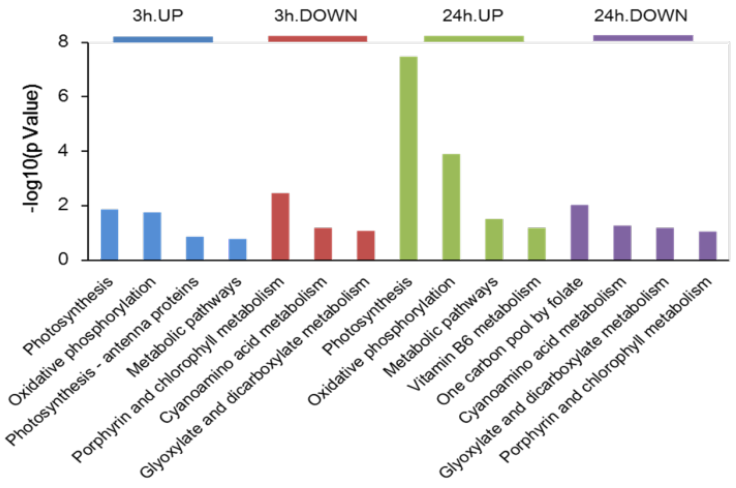
Figure 3. Kyoto Encyclopedia of Genes and Genomes (KEGG) pathway enrichment analysis of the DAPs in Dunaliella salina exposed to salt stress at 3 and 24 h. The x -axis shows representative enriched KEGG pathways, and the y-axis indicates corresponding p-values of enriched pathways (−log10 p value).